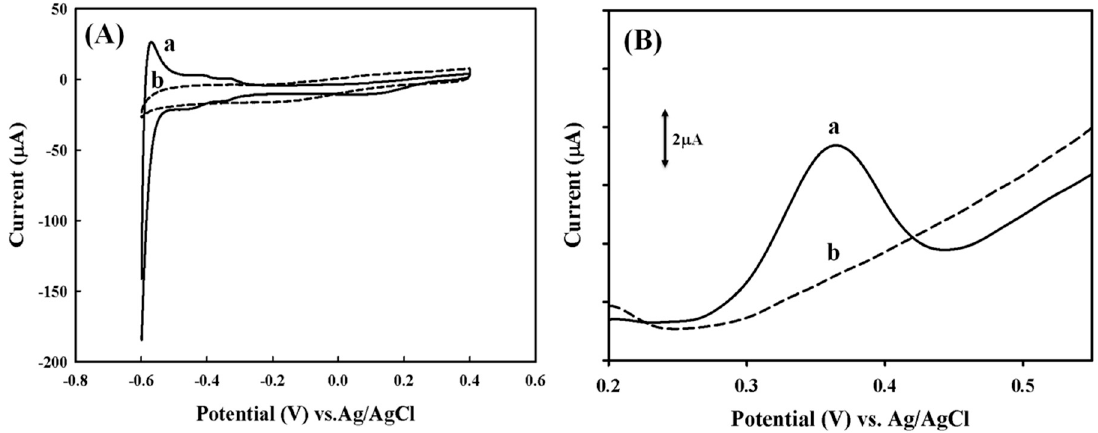
Figure 4. ( A ) CV profiles of (a) Pt, and (b) PEDOT/PEDOT:PSS/Pt electrodes in response to 0.1 m PBS buffer (pH = 6.2). ( B ) DPV profiles of (a) PEDOT:PSS/Pt and (b) PEDOT/PEDOT:PSS/Pt electrodes in response to 1 μ M of DNM.